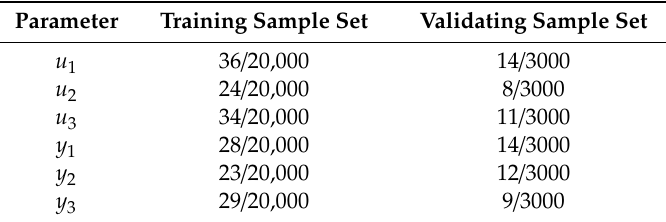
Table 1. The number of outliers in training and validating sample sets.